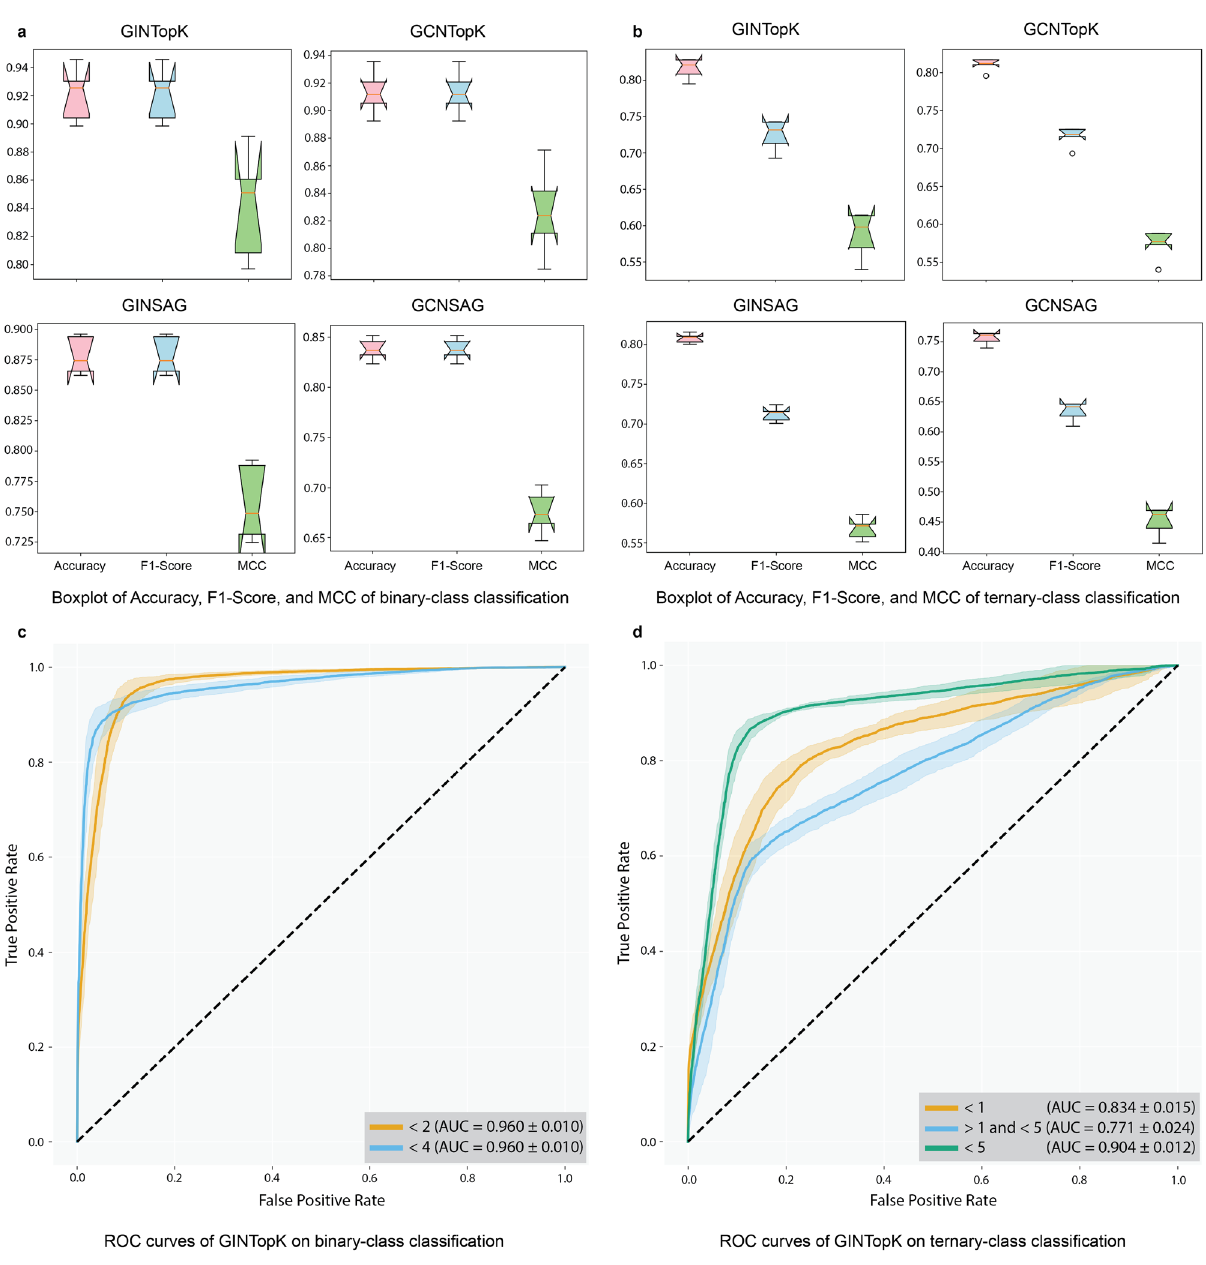
Fig. 2 Model performance of four GNNs on fi vefold cross-validation. a , b show the Boxplots of performance metrics of Accuracy, F1-score, and MCC on fi vefold cross-validation. c , d illustrate the ROCs of GINTopK binary- and ternary models on fi vefold cross-validation. In the boxplot, the center line marks the mid-point of the data; the top and bottom lines show the maximum and minimum non-outlier data; the upper and lower bounds of the box indicate the third quartile and fi rst quartile of the data; the height of the notch indicates the 95% con fi dence interval of the median point; small circles represent According to Table 2, the variant models trained using these feature subsets and all-feature sets achieved comparable Accuracy values in both binary and ternary classi fi cations. In the binary